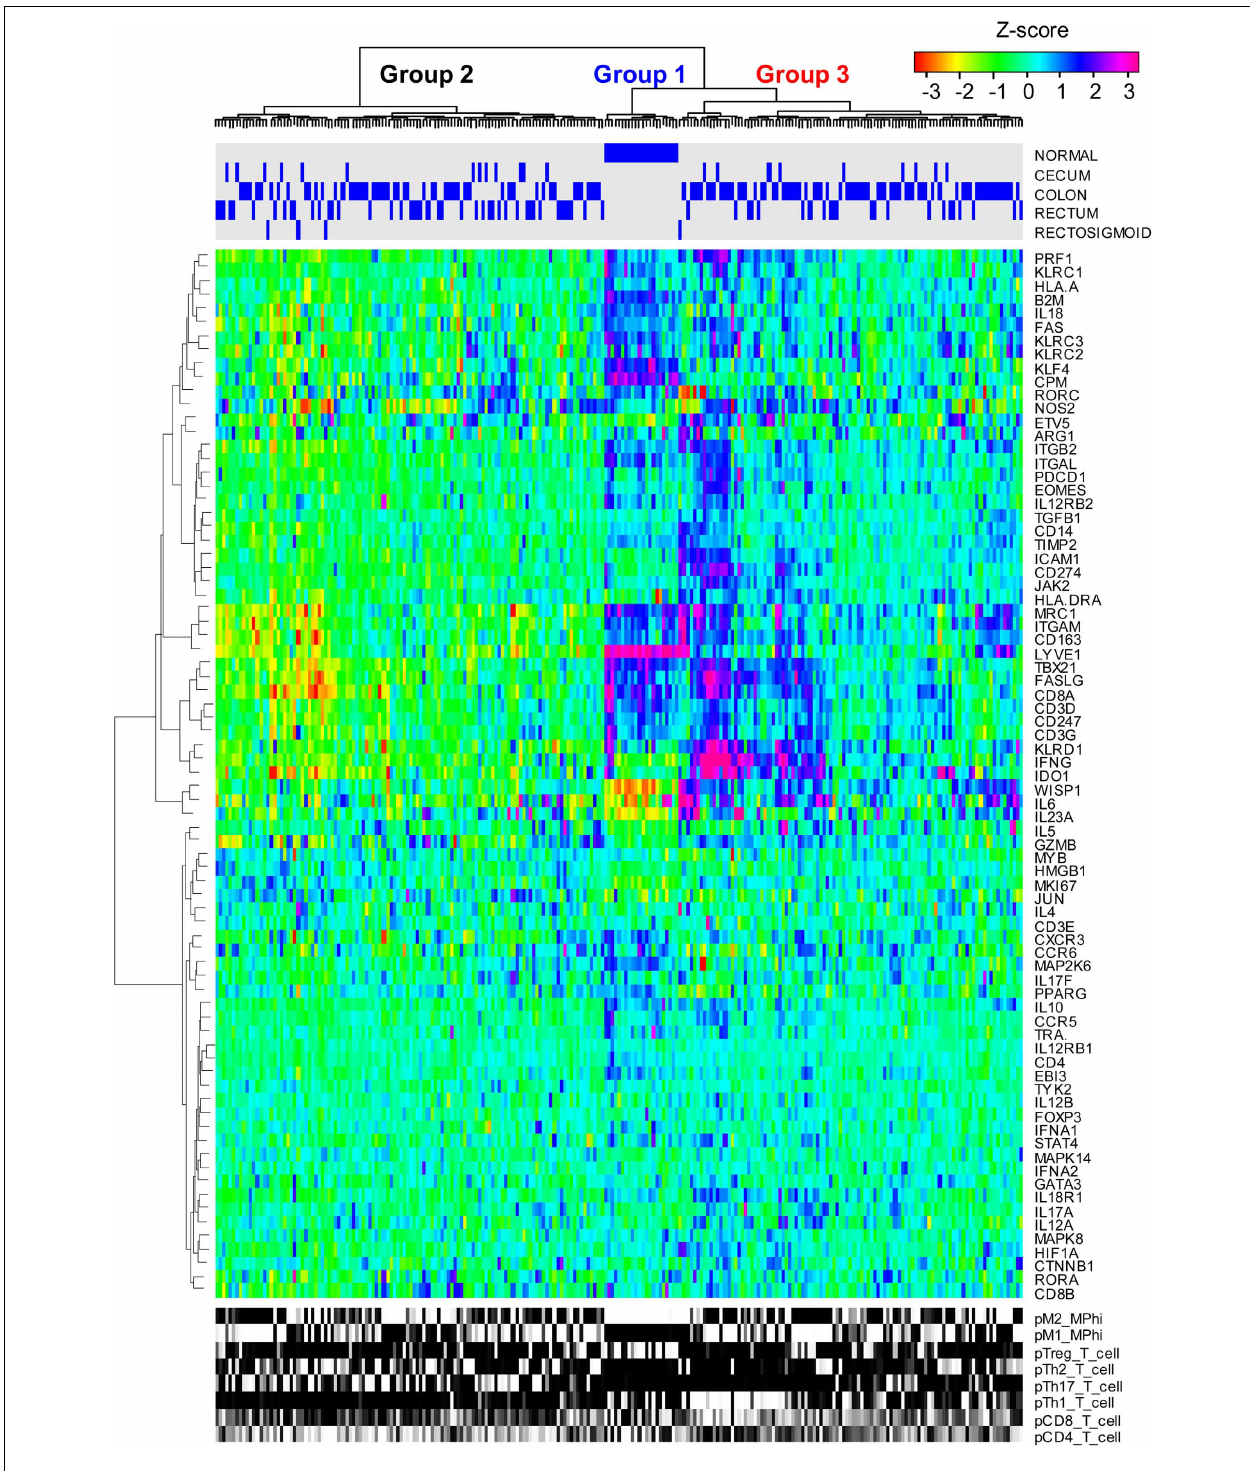
FIGURE 2 | Immune gene expression signatures in colorectal cancer clusters into three groups. mRNA expression obtained from normal colorectal and cecum, colon, rectum, and rectosigmoid adenocarcinoma tissue samples (columns) were hierarchically clustered into three groups based upon the log2 median normalized expression ratio for genes (rows) related to cell-mediated cytotoxic immunity and tumor